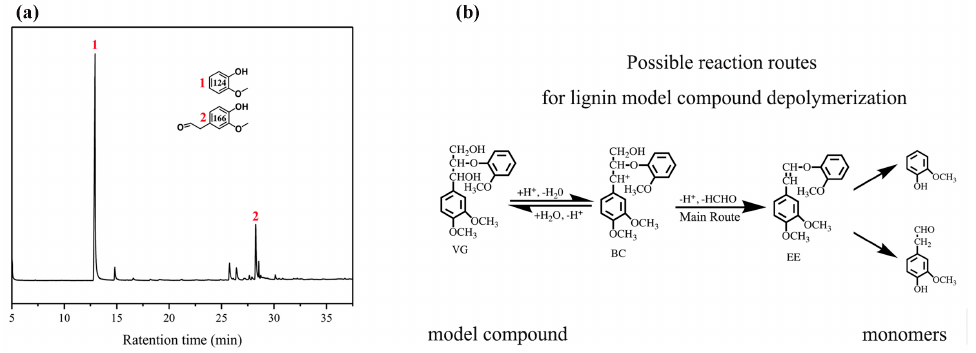
Figure 3. Phosphotungstic acid (PTA) catalytic depolymerization of the lignin model compound. ( a ) A gas chromatogram of the veratrylglycerol- β -guaiacyl ether under the PTA catalyst; ( b ) possible